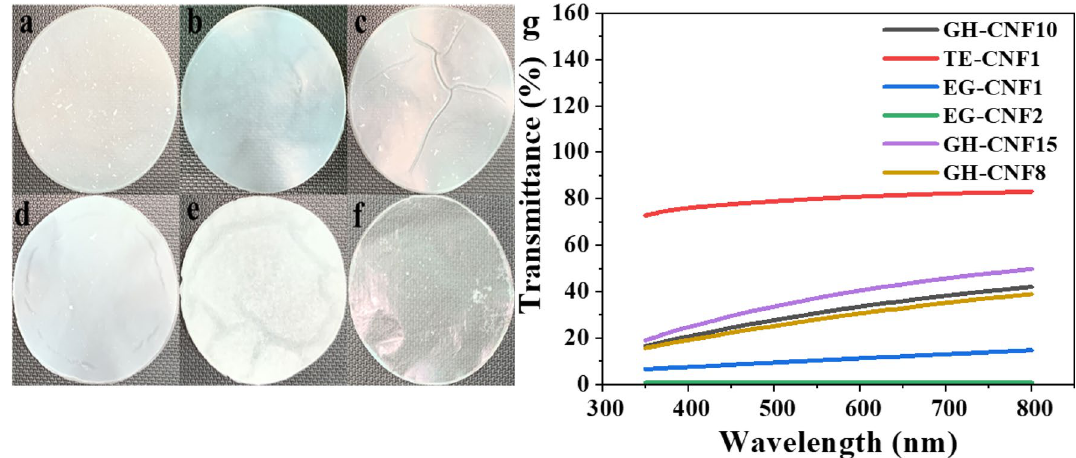
Figure 6. Profile of prepared CNF films. ( a ) GH-CNF8, ( b ) GH-CNF10, ( c ) GH-CNF15, ( d ) EG-CNF1, ( e ) EG-CNF2, ( f ) TE-CNF1, and ( g ) UV spectra of TE-CNF1, GH-CNF15, GH-CNF10, GH-CNF8, EG-CNF1, and